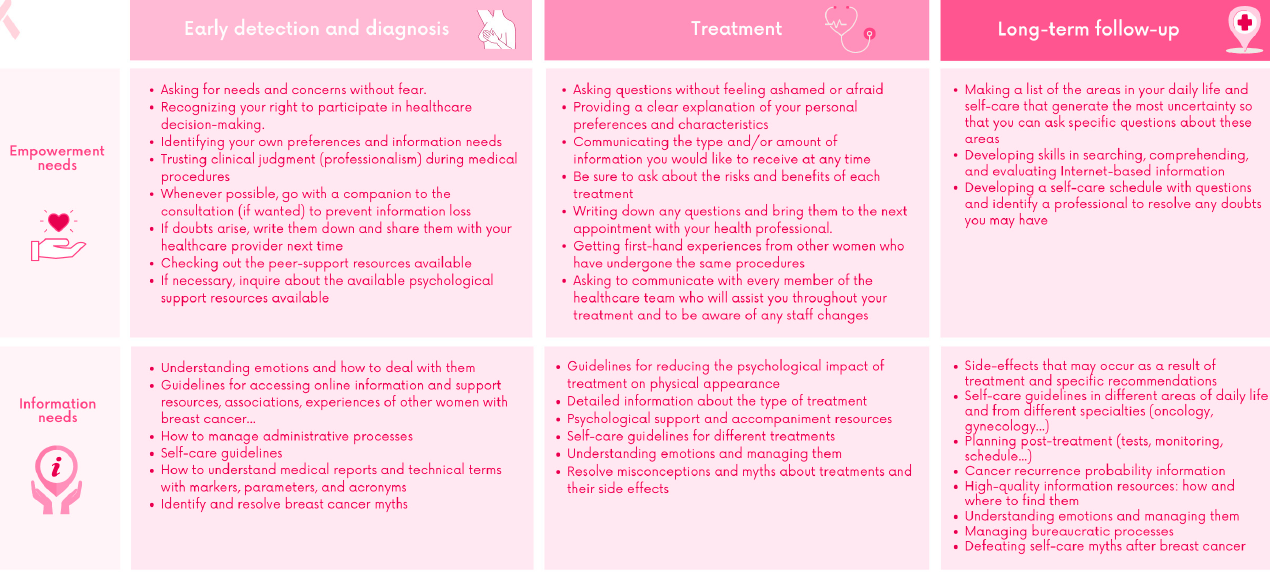
Figure 3. Empowerment and information